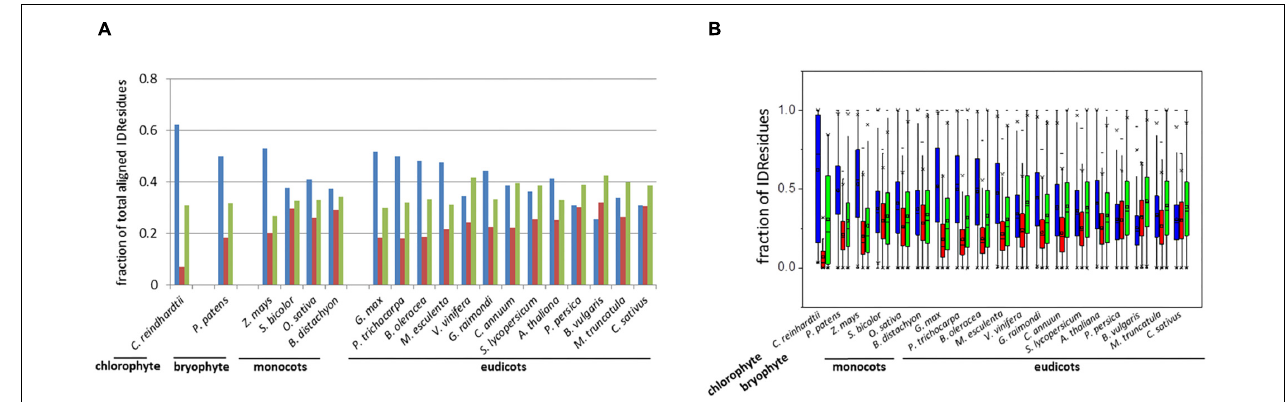
FIGURE 1 | Bar-plot of the fraction (A) and box-plot distribution (B) of total aligned IDResidues. Identical IDRs (blue), similar IDRs (red), and variable IDRs (green) based on PONDR VSL2b